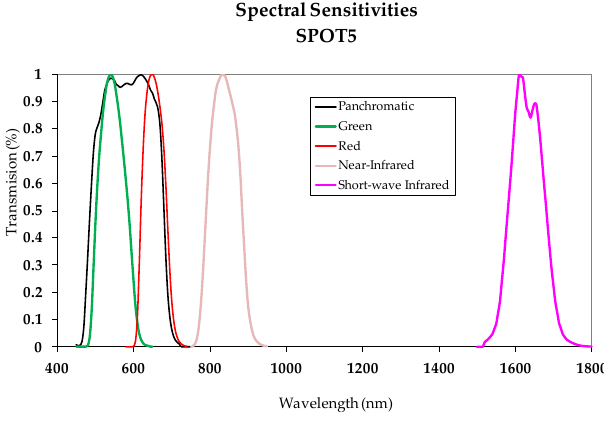
Figure 4. SPOT 5—spectral sensitivities (from Renza et al., 2011).